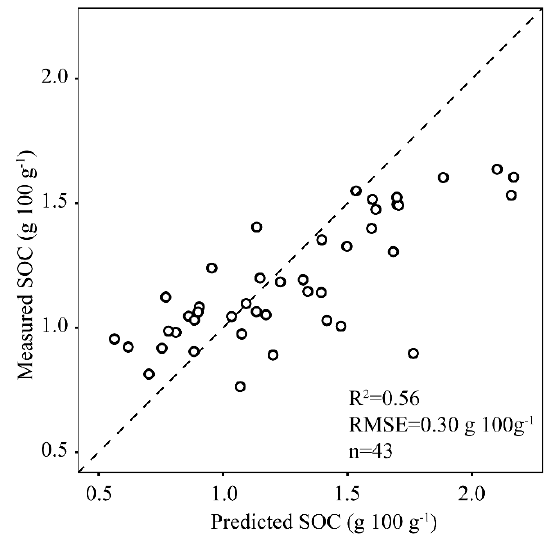
Figure 5. Scatterplot of measured versus predicted SOC using the independent validation dataset.